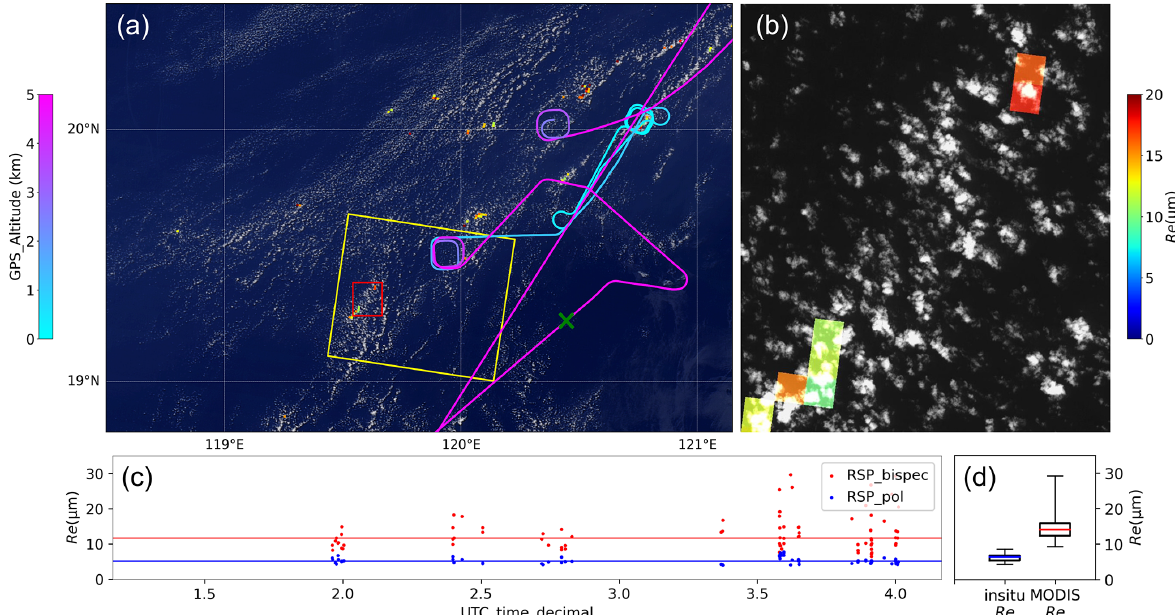
Figure 6. (a) MODIS 250m RGB reflectance at MODIS overpass (02:40UTC) overlaid by MODIS Level 2 liquid R e retrievals for the RF17 P-3 flight path within 1.5h of the MODIS overpass; the flight path is color-coded by altitude, the green cross indicates the P-3 position at the MODIS overpass time, the yellow box indicates the outline of the co-located ASTER 15m granule, and the red box indicates the outline of the close-up view shown in panel (b) . (b) Close-up view of ASTER 15m resolution Band 3 nadir (3N) radiance, overlaid by MODIS Level 2 liquid R e retrievals. (c) Scatterplot of RSP polarimetric and bi-spectral R e retrievals within 1.5h of the MODIS overpass time; the blue and red lines indicate the median value for the RSP polarimetric and bi-spectral R e retrievals, respectively. (d) Box plots of the MODIS R e retrievals shown in panel (a) and P-3 R e derived in situ within 1.5h of the MODIS overpass time; the line in the box indicates the median R e value.